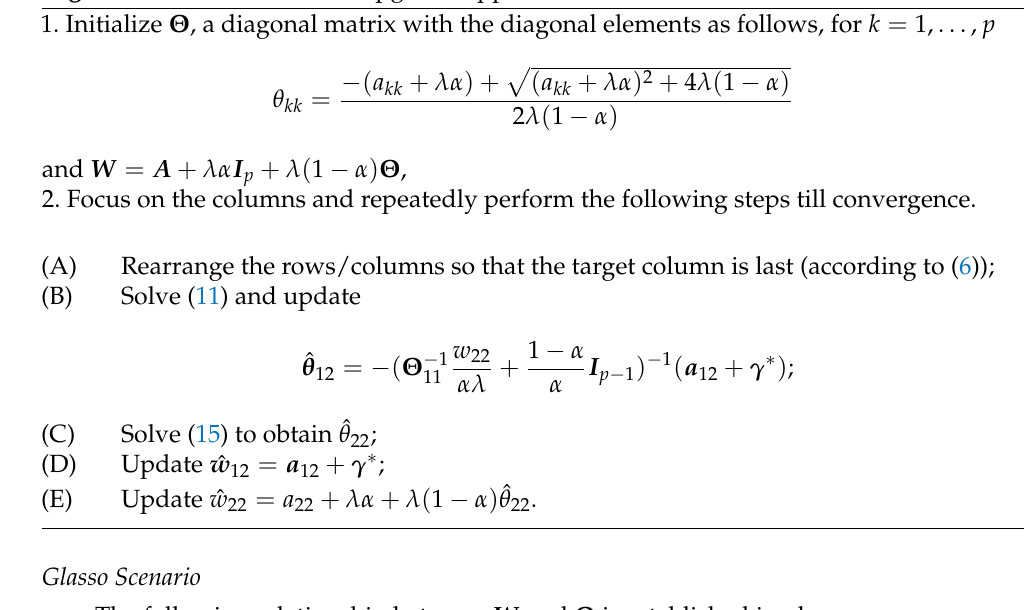
Algorithm 1 GSOS based on dpglasso